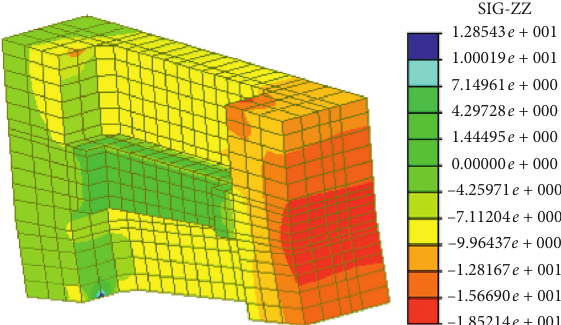
Figure 13: Normal stress distribution diagram after setting of the stiffening plate at the bending corner of the main tower Table 4: Comparison table of stresses at each measuring point of corner section T2-1 of main tower (unit: MPa). Dead load+live load Part Measuring point number Without stiffener With stiffener Measured value of model test 1 Mid-span side 4 Upstream side